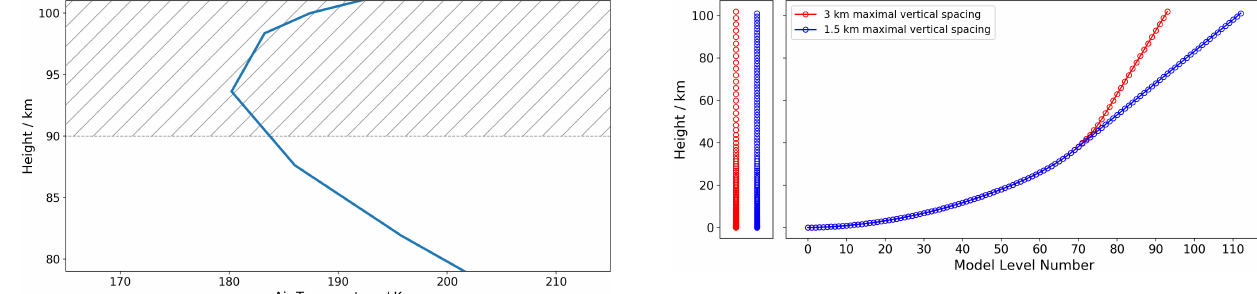
Figure 3. Vertical level sets for the 3km maximal vertical spacing (red) and the 1.5km maximal vertical spacing